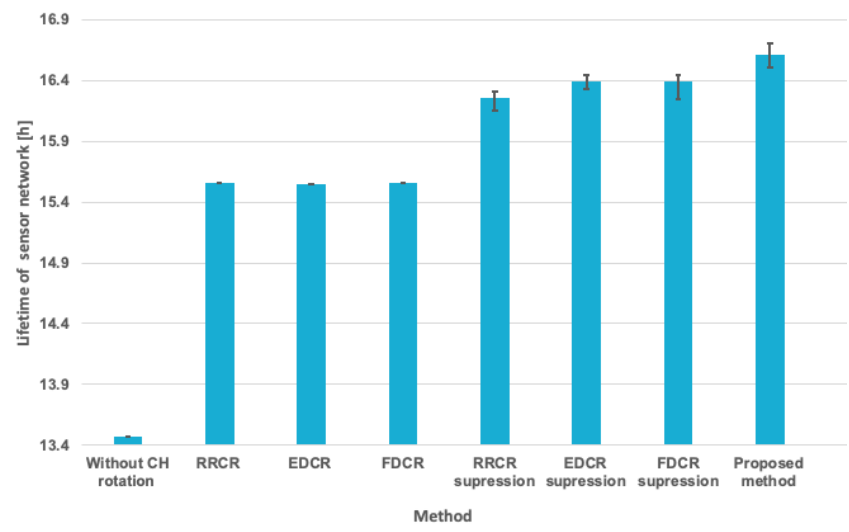
Figure 18. Summarized results of WSN lifetime evaluation for all analyzed